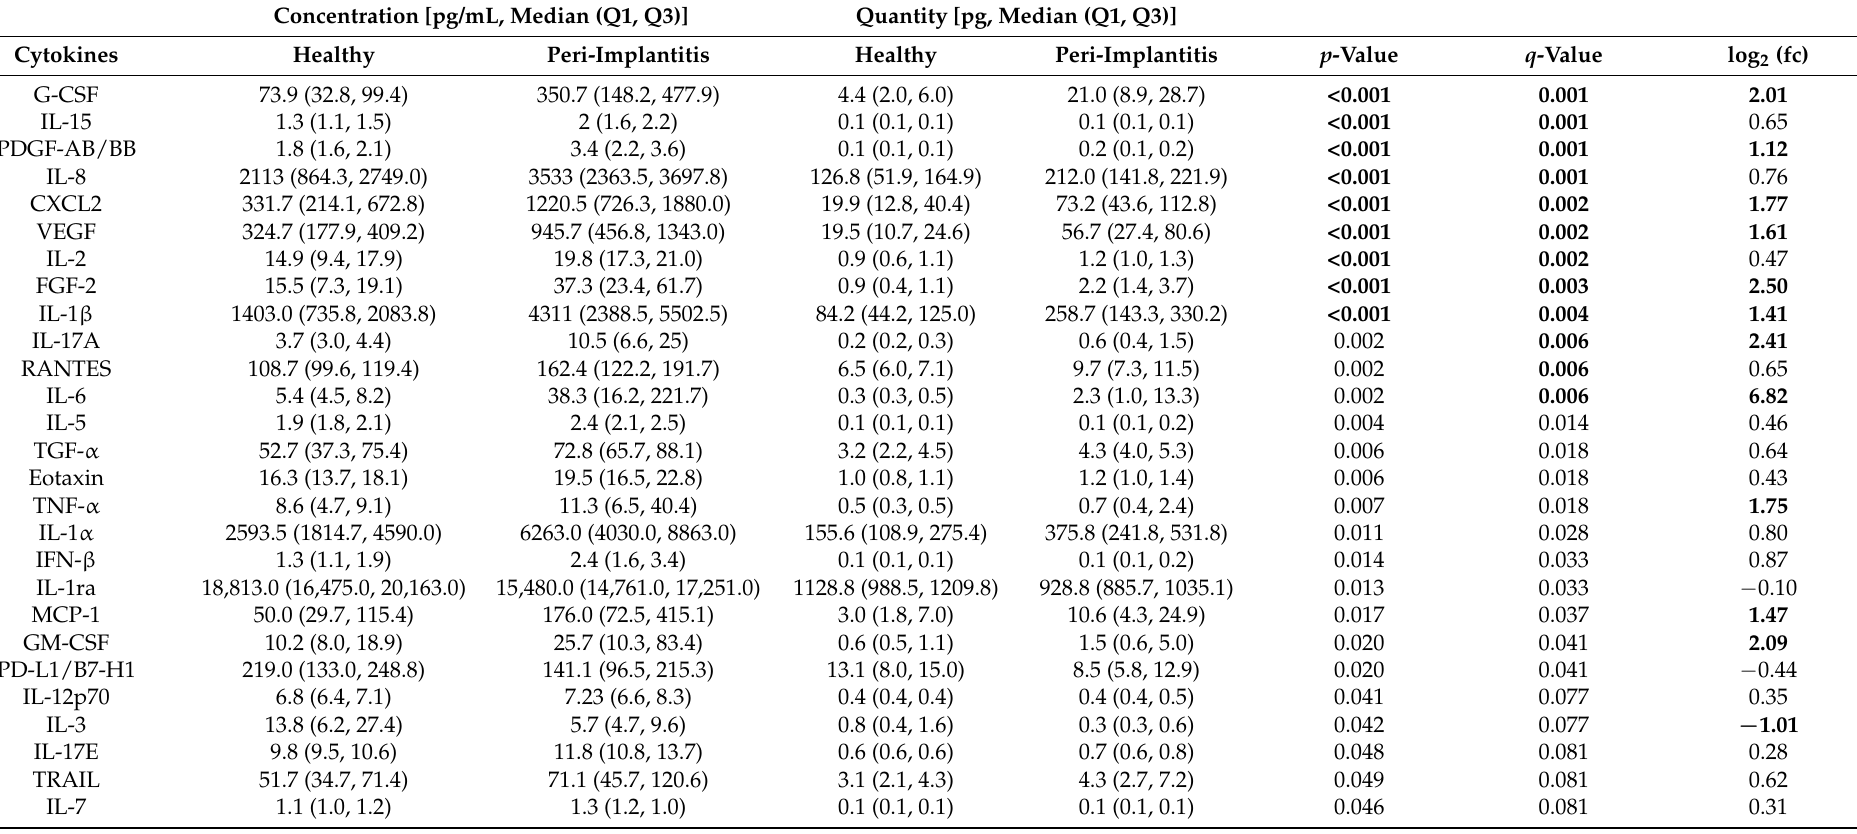
Table 2. Cytokine levels in PICF between healthy implants and